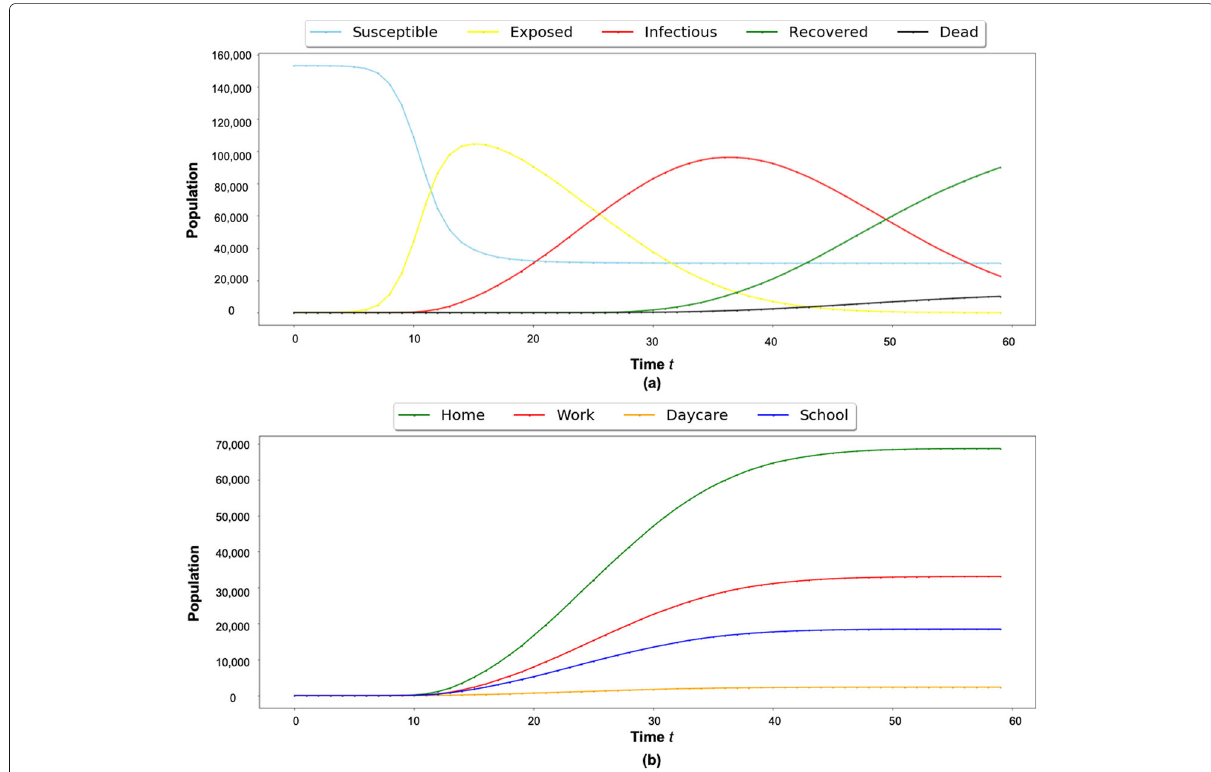
Fig. 17 Disease Model Results: ( a ) SEIR Results; ( b ) Exposed Locations